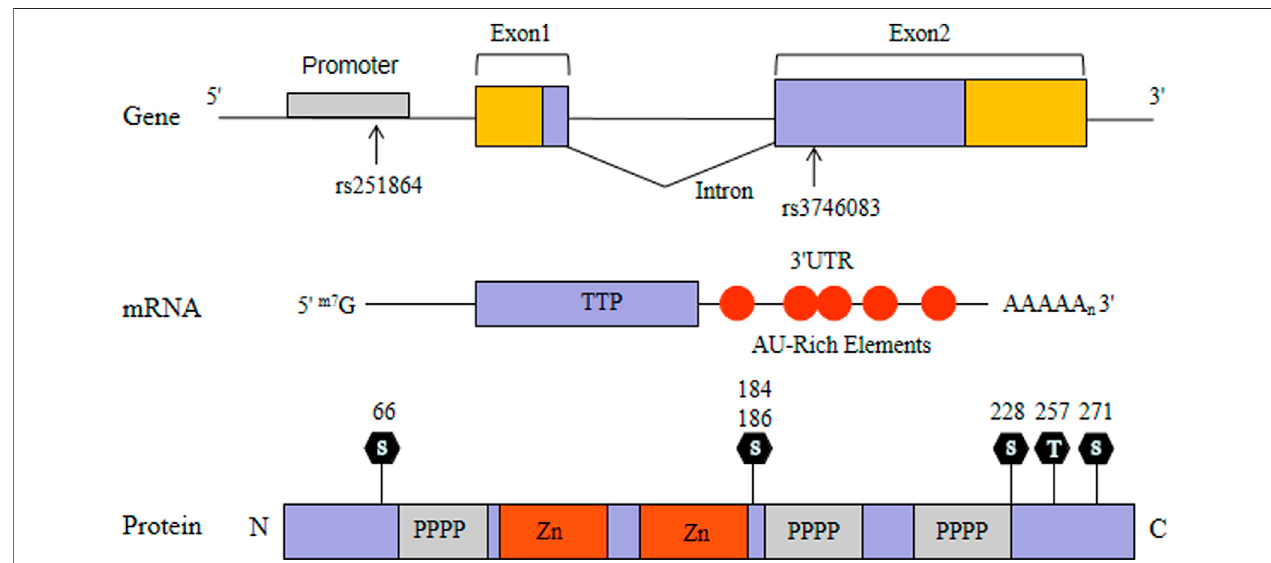
FIGURE 1 | Schematic showing the organization of TTP gene, mRNA, and